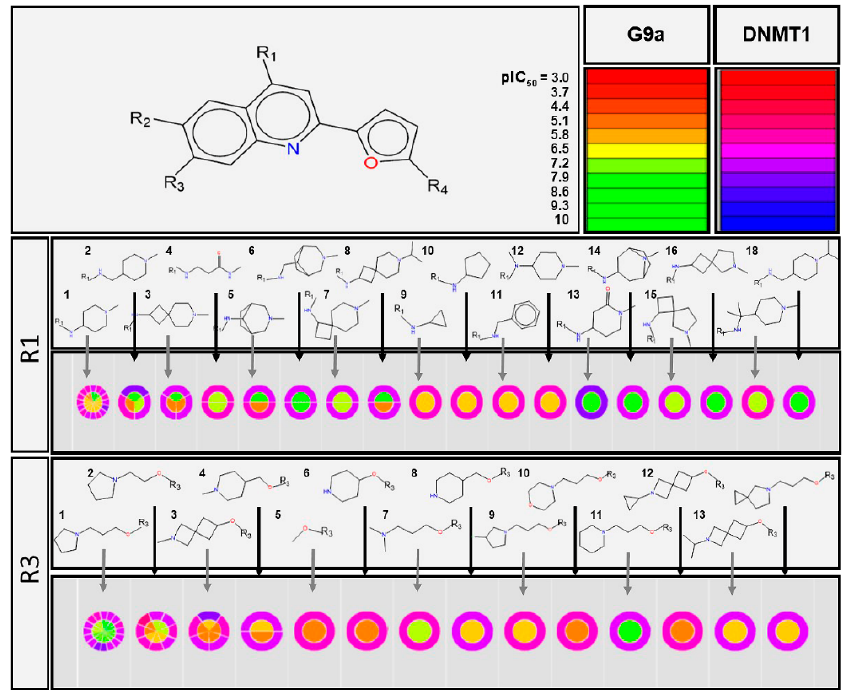
Figure 2. Visual representation of the activity data for compounds with different R 1 and R 3 substituents on the dual activity of compounds against G9a and DNMT1. The graph was generated with the SAReport of Molecular Operating Environment.